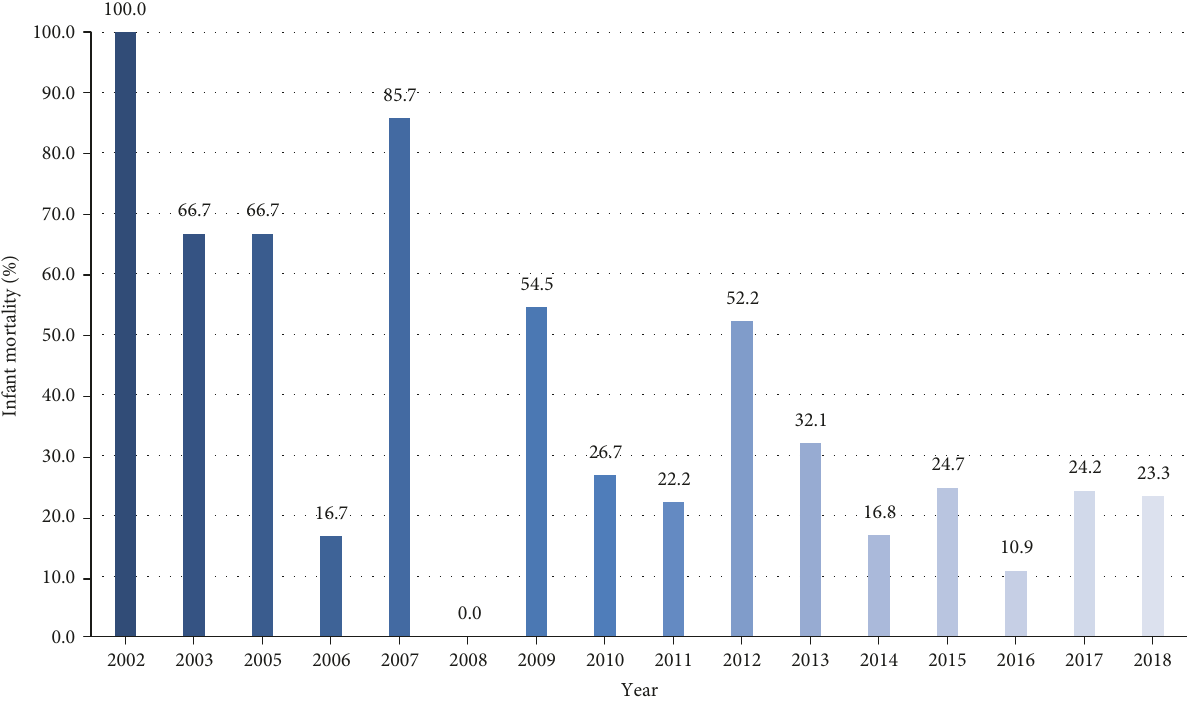
Figure 9: Infant mortality for CubeSats from 2002 up to May 31, 2018 (launch failures excluded).